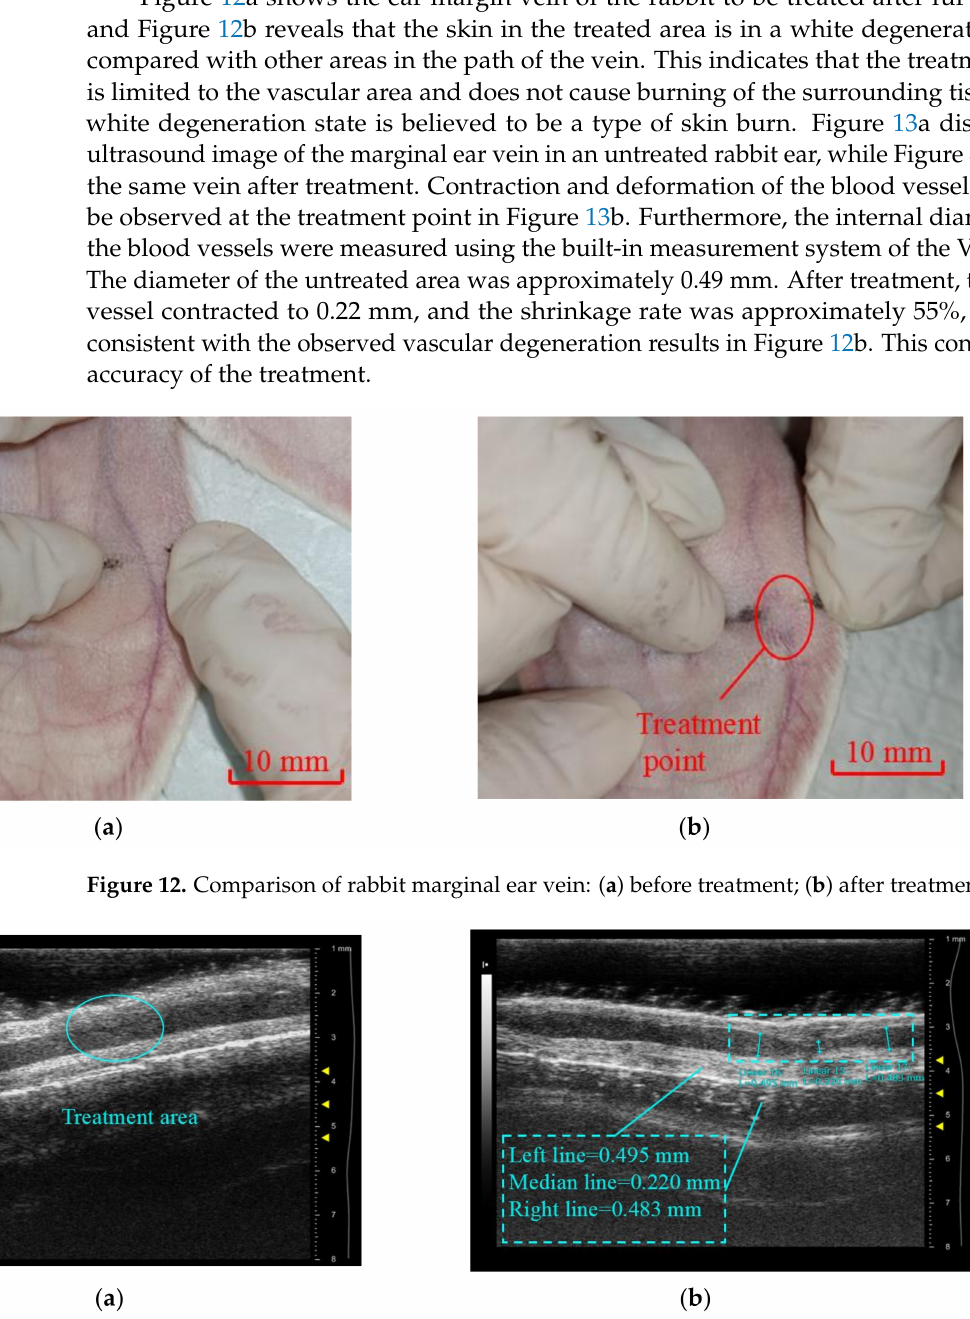
Figure 13. The contrast image of rabbit ear vein contraction: ( a ) before treatment; ( b ) after